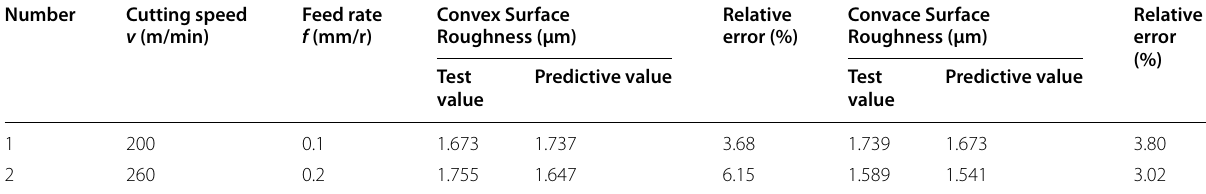
Table 6 Analysis results of surface roughness error Number